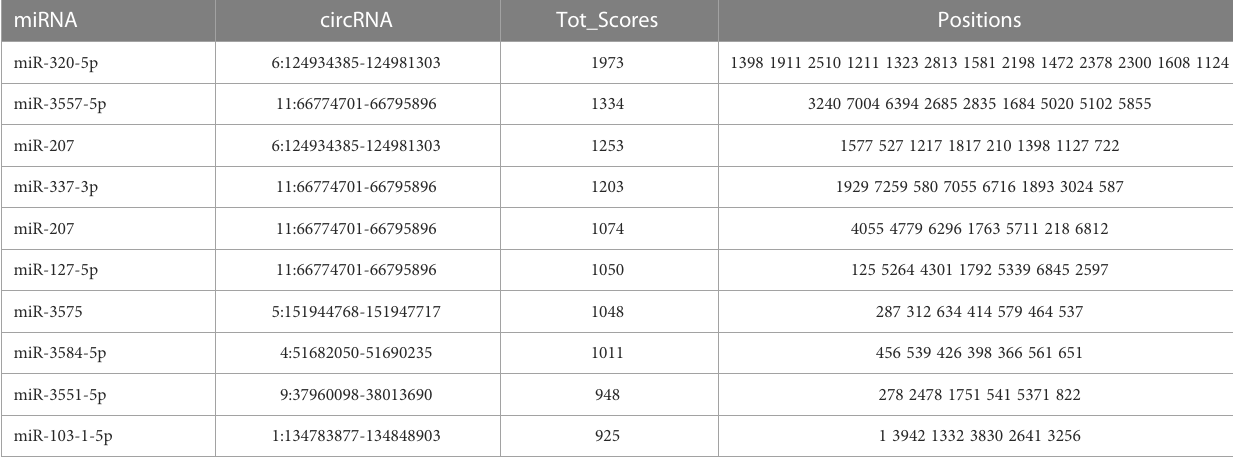
TABLE 1 The top 10 miRNA-circRNA interaction pairs ranked by Tot_scores. miRNA circRNA Tot_Scores Positions